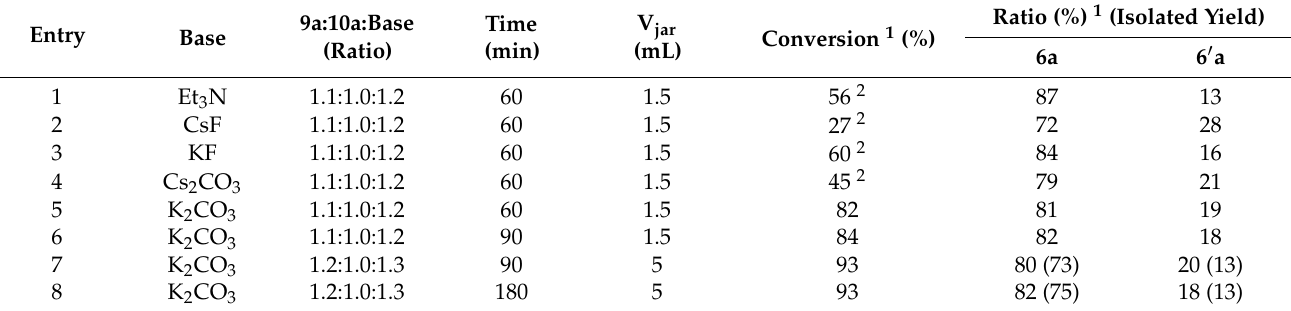
1 Estimated based on 1 H NMR spectra of crude reaction mixtures; 2 Partial decomposition of starting bromide 9a .